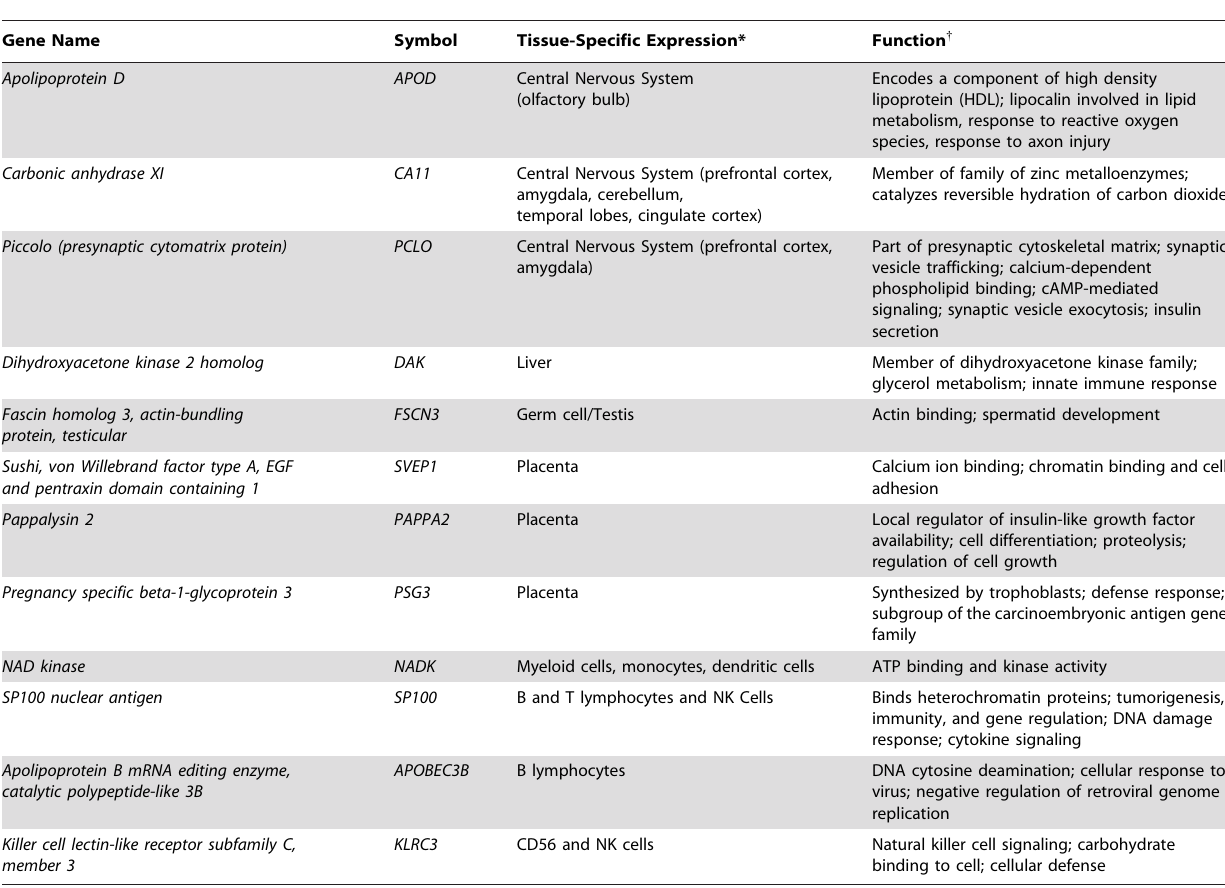
Table 7. Tissue-specific gene expression in fetuses of obese